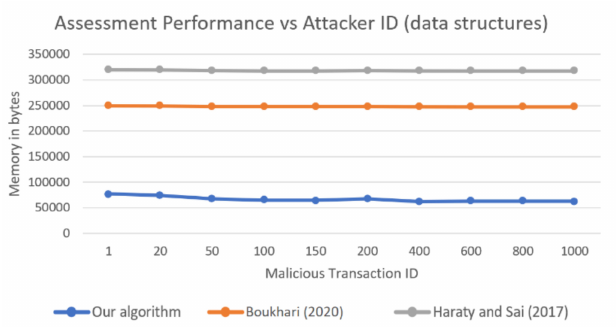
Figure 8. Comparison of the data structure memories (ignoring thread overhead memory) used by three algorithms as a function of the malicious transaction